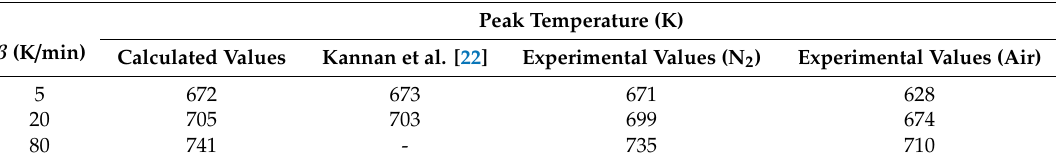
Figure 2. DTG and the conversion rate curves in nitrogen and air: ( a ) DTG (nitrogen), ( b ) α (nitrogen), ( c ) DTG (air) and ( d ) α (air). Table 2. Comparison of calculated peak values of EPS and experimental temperature using an empirical formula.